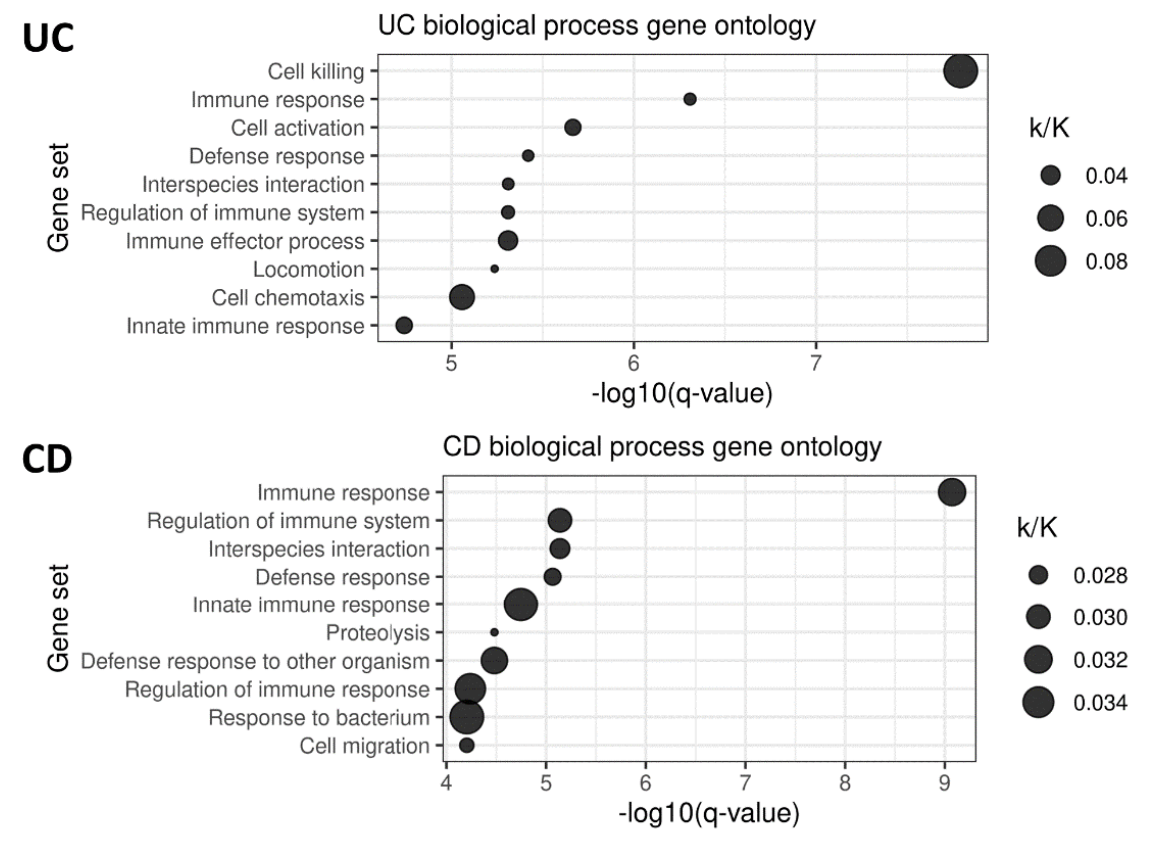
Figure 1. Gene ontology analysis of the genes included in the lasso models for the prediction of IBD, UC, and CD status. The ratio of the number of genes in overlap (k) to all genes in the given gene set (K) is indicated.